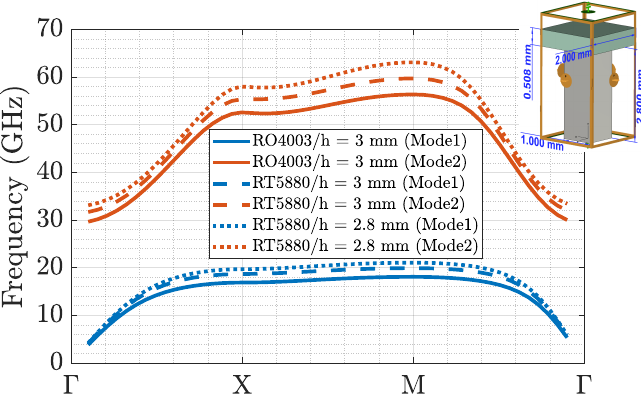
Figure 1. Dispersion diagram comparison between Rogers RT5880 TM and RO4003C TM substrates ( t = 0.508 mm; h = 2.8 mm or 3 mm; g = 0.5 mm, p = 2 mm, a = 1